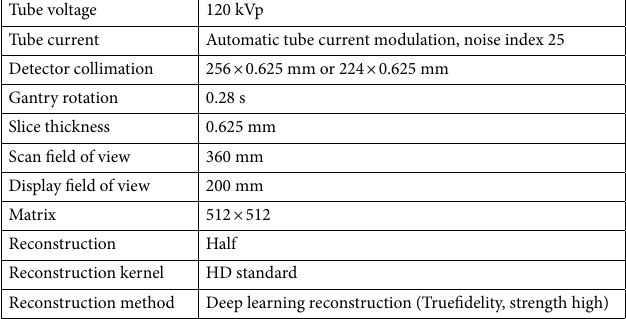
Table 1. CT acquisition